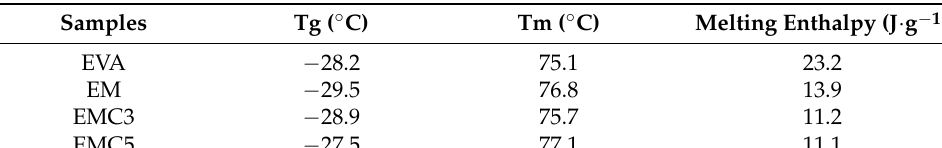
Table 4. DSC Results of the composites.